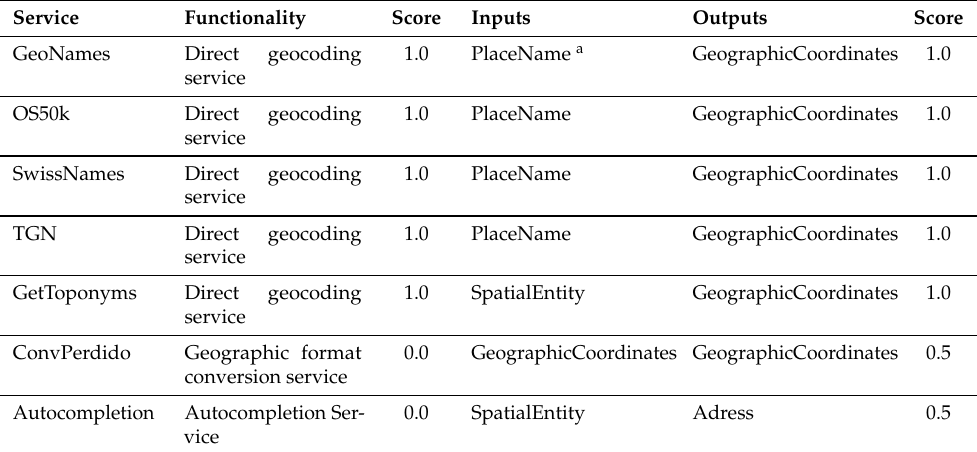
Table 6. Results of request R2